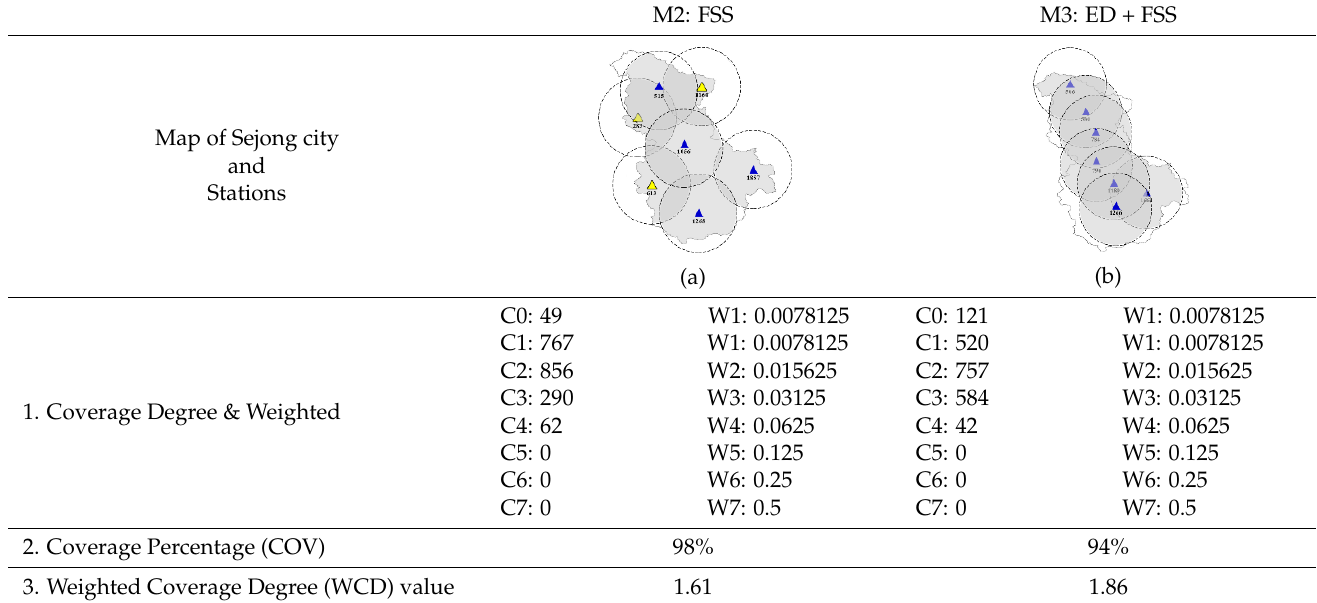
Figure 7. Plot of historical coverage percentage versus number of stations in Sejong. Next, we investigated the additional stations of M2: FSS. As shown in Table 4 (a), light color of triangle symbols indicated the three additional stations which are located close to the border. Table 4. The results of stations, coverage percentages, and weighted coverage degrees of two methods: M2: FSS and M3: ED + FSS.